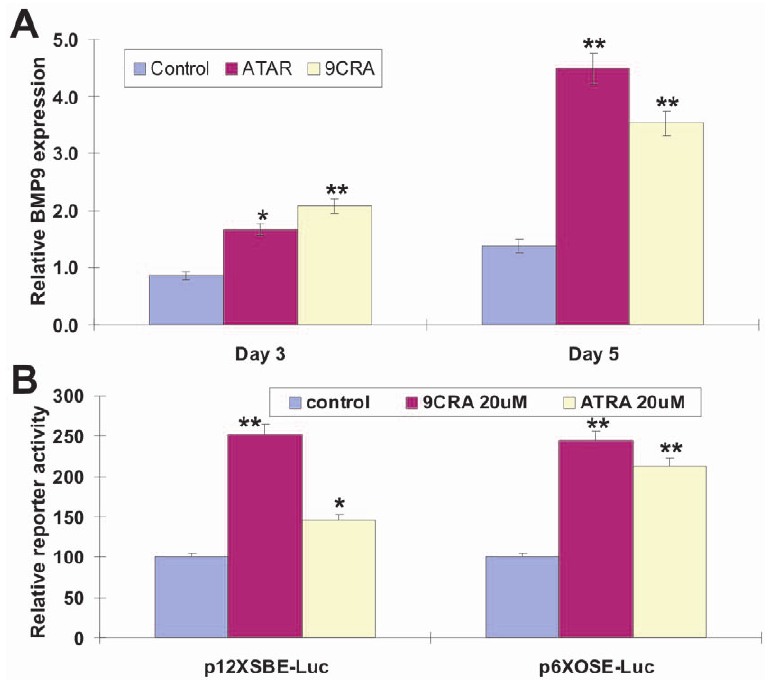
Figure 4. Retinoids induce BMP9 expression and activate BMP-Smad pathway. ( A ) Retinods induce BMP9 expression in MPCs. Subconfluent MEFs were treated with 9CRA (20 m M), ATRA (20 m M), or solvent control. At day 3 and day 5, the cells were collected for total RNA isolation. RNA was subjected to RT-PCR transcription, which was used as templates for qPCR analysis using primers specific for mouse BMP9. Each assay condition was carried out in triplicate. All samples were normalized using endogenous levels of GAPDH. ‘‘*’’, p , 0.05 ; ‘‘**’’, p , 0.01 (vs. control groups). ( B ) Retinods activate BMPR Smad reporter and Runx2 reporter activity in MPCs. MEFs were transfected with BMPR Smad reporter, p12xSBE- Luc or OC promoter containing Runx2-responsive element reporter, p6xOSE-Luc. The transfected cells were replated at 16h after transfection, followed by a treatment with 9CRA (20 m M), ATRA (20 m M), or solvent control. 48 h after treatment, the cells were lyzed for luciferase activity assay using Promega’s Luciferase Assay kit. Each assay condition was carried out in triplicate. Luciferase activity was normalized by total cellular protein concentrations among the samples. ‘‘*’’, p , 0.05 ; ‘‘**’’, p , 0.001 (vs. control groups).